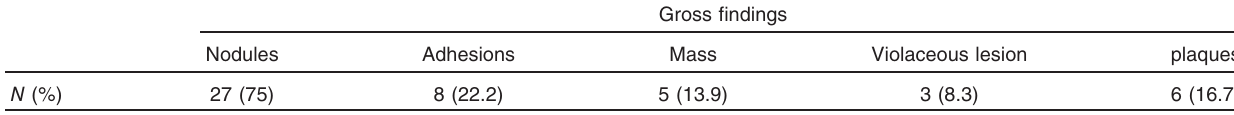
Table 3 Different gross thoracoscopic findings of studied patients